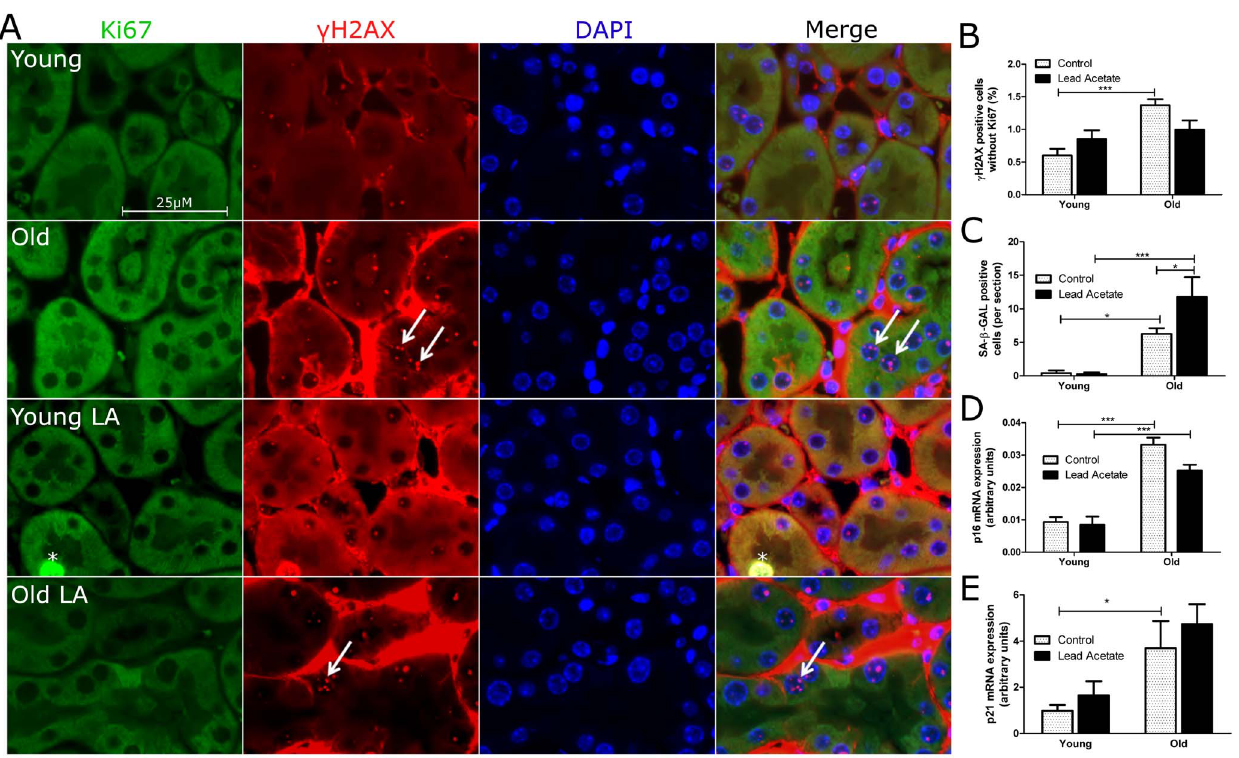
Figure 4. Lead acetate treatment does not alter senescence markers in cells in the kidneys of old mice. (A) Representative double immunostainings for phospho- c H2AX (red) and Ki-67 (green) in kidney sections from young and old mice with or without lead acetate treatment. Nuclei with more than 4 foci were considered positive (arrowheads) while double positive cells were not considered senescent (asterisk); red staining in the interstitial space is due to secondary antibody binding to native IgG; original magnification 400 6 . (B) Quantification of c H2AX positive and Ki- 67 negative nuclei. (C) Quantification of SA- b -GAL positive cells. (D) Quantitative PCR for p16 INK4a . (E) Quantitative PCR for p21. n=5, Data are mean values 6 SEM. *P , 0.05; **P , 0.01; ***P , 0.001.